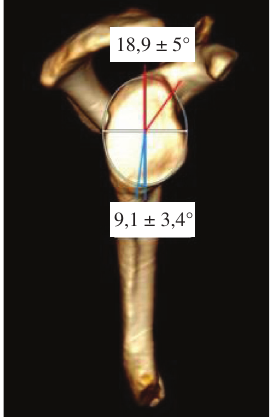
Figure 4. Distance between the upper edge of PM tendon to change of curvature (1), great tubercle (2), humeral head (3), and anatomical neck.